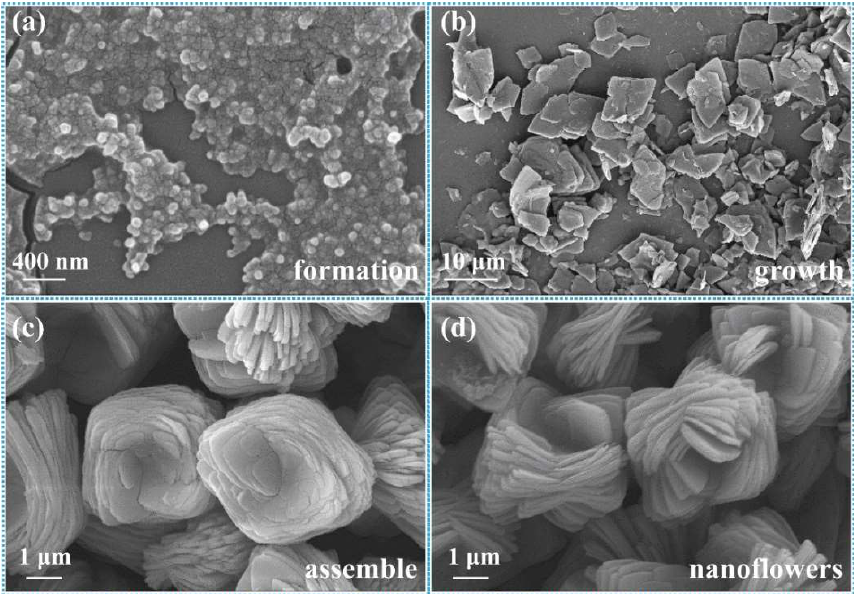
Figure 4. SEM images of trypsin/Zn 3 (PO 4 ) 2 hybrid nanoflowers obtained under different reaction times: ( a ) 10 min, ( b ) 20 min, ( c ) 60 min and ( d ) 120 min.